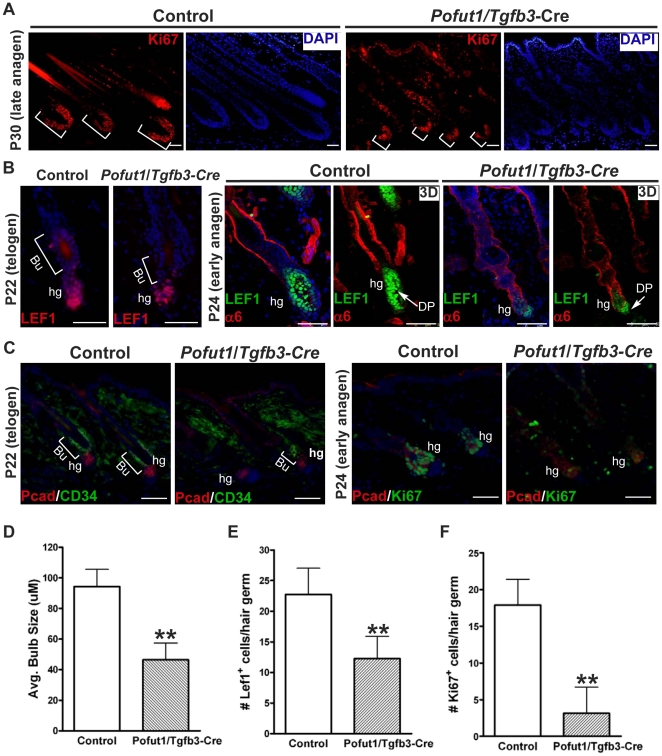
Inactivation of Pofut1 in hair follicle lineages results in a defect in anagen re-entry.(A) Back skin samples from control and Pofut1/Tgfb3-Cre mice at P30 were immunostained for Ki67. bracket: proliferating (Ki67+) hair bulb matrix cells. (B, C) Back skin samples from control and Pofut1/Tgfb3-Cre mice at P22 (telogen) and P24 (early anagen) were immunostained for Lef1 (B, P22), double-stained for Lef1 and α6-integrin (α6) (B, P24), double-stained for P-cadherin (Pcad) and CD34 (C, P22), and double-stained for Pcad and Ki67 (C, P24). Confocal serial sections of Lef1 and α6 immunostaining were reconstructed to generate 3D images tilted at 45° on Z-axis (3D). (D) Quantification of the size of hair bulbs from control and Pofut1/Tgfb3-Cre mice at P30. A bar diagram shows the length of hair bulbs (mean+/−s.d., n = 30) from two independent control and mutant pairs, **: P<0.01. (E, F) Quantification of the Lef1-positive (Lef1+) and Ki67-positive (Ki67+) cells in the hair germ from control and Pofut1/Tgfb3-Cre mice at P24. Bar diagrams show the number of Lef1+ cells (E) and Ki67+cells (F) per hair germ (mean+/−s.d., n = 60) from two independent control and mutant pairs, **:P<0.01. Antibodies used are color-coded according to fluorophore-tagged secondary antibodies. DAPI counterstaining in blue. Bu: Bulge, hg: hair germ, DP: dermal papilla. Scale bar, 50 µM.